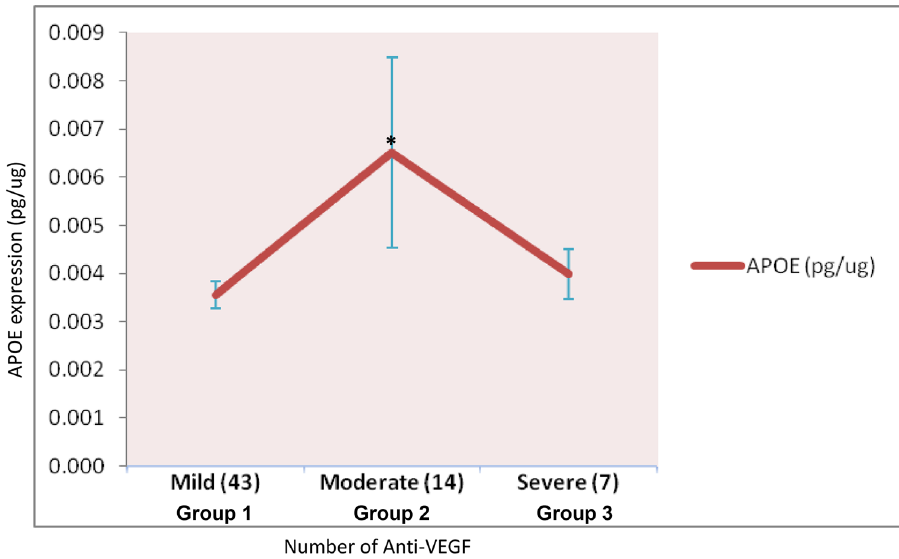
Figure 3. APOE expression in mild, moderate and severe groups of anti-VEGF response is based on the number of injections in wet AMD patients. Significantly higher levels of APOE were seen in moderate group as compared to mild group. Bar is representing SEM; P < 0.05.